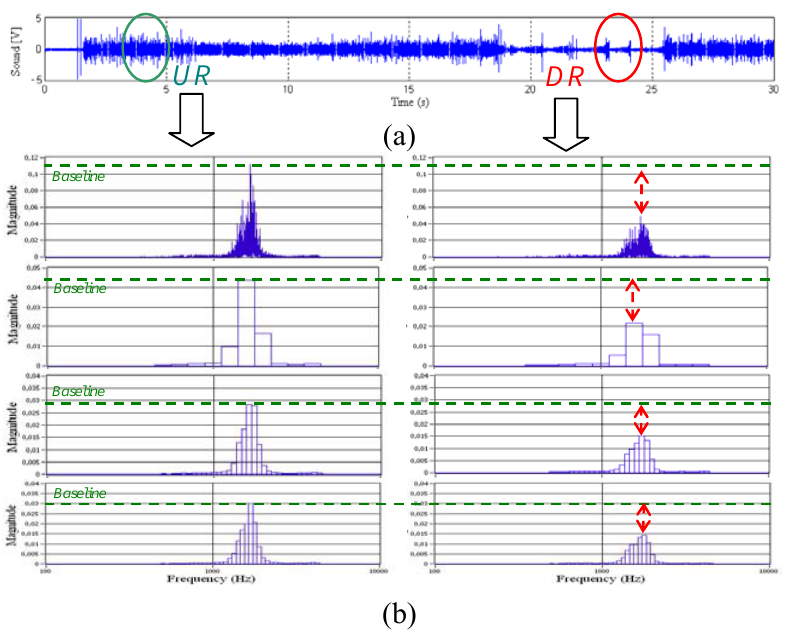
Figure 9. Frequency Profiles to welding arc